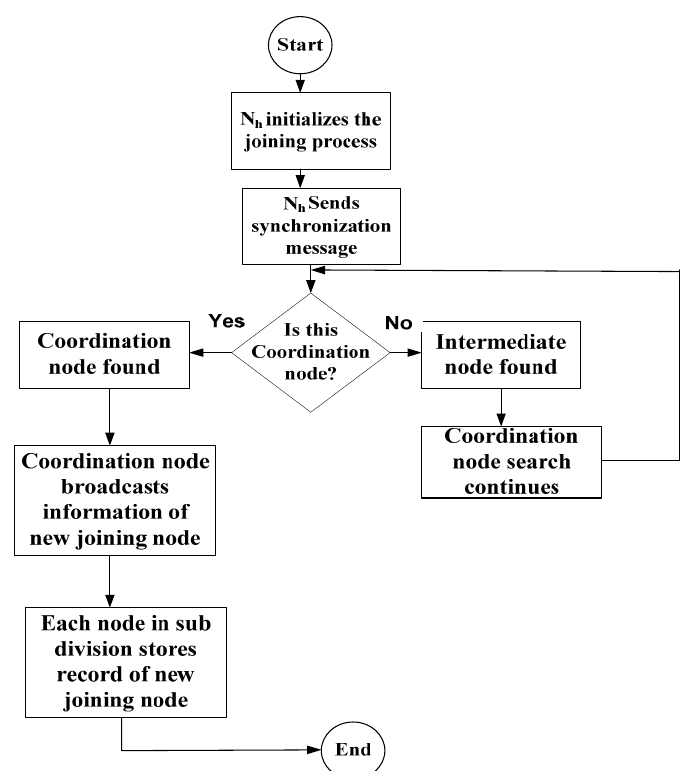
Figure 2. Coordination node synchronization process.